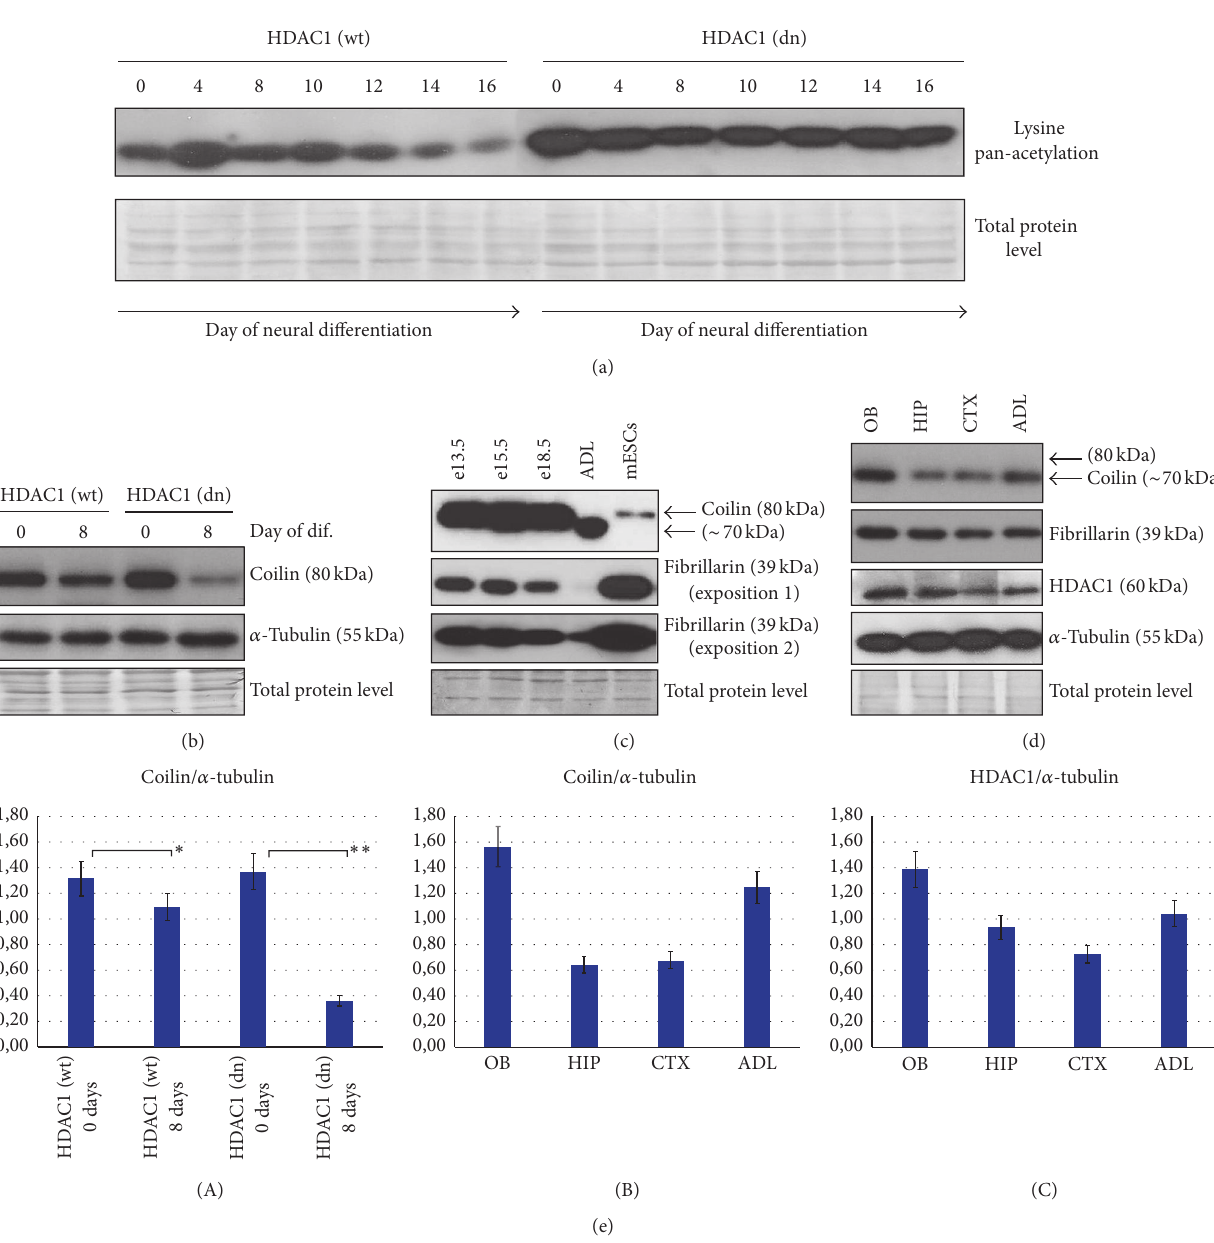
Figure 4: The levels of coilin, HDAC1, and fibrillarin in pluripotent and differentiated mouse ESCs and in the mouse brain. (a) In comparison to nondifferentiated and differentiated wt mESCs, a very high level of lysine pan-acetylation was found in HDAC1 dn cells and in their differentiatedcounterpart.NeuraldifferentiationwasinducedinbothwtandHDAC1dncellsbyidenticaldifferentiationprotocol.(b)Western blotshowscoilinand 𝛼